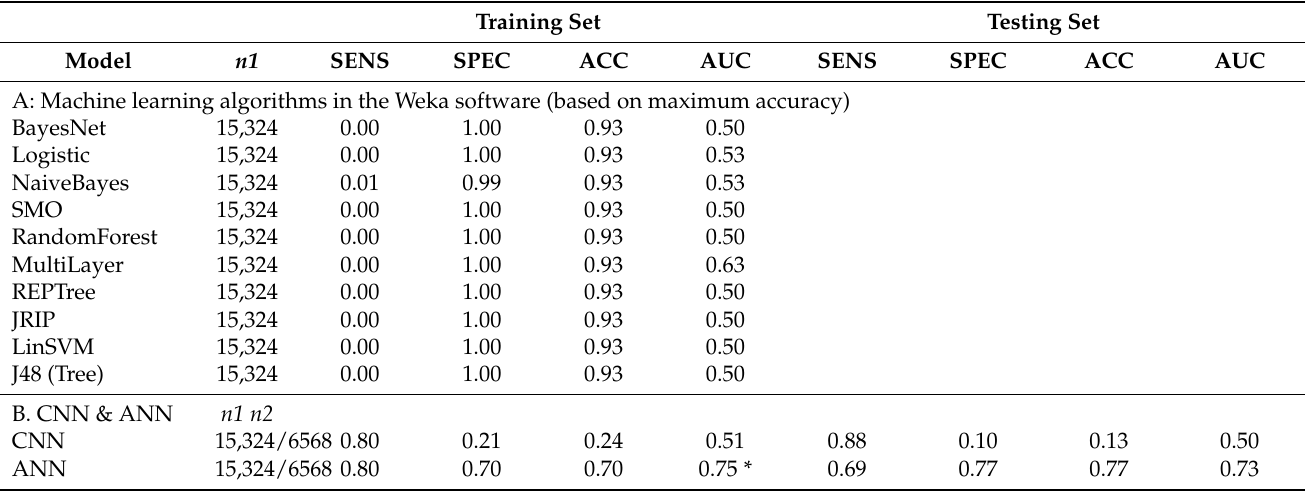
Table 1. Comparison of statistics in models for accuracy and stability using AUC in the evaluations. Training Set Testing Set